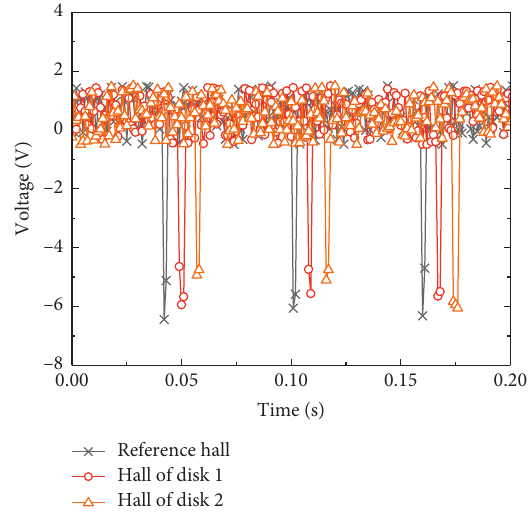
Figure 6: Simulation